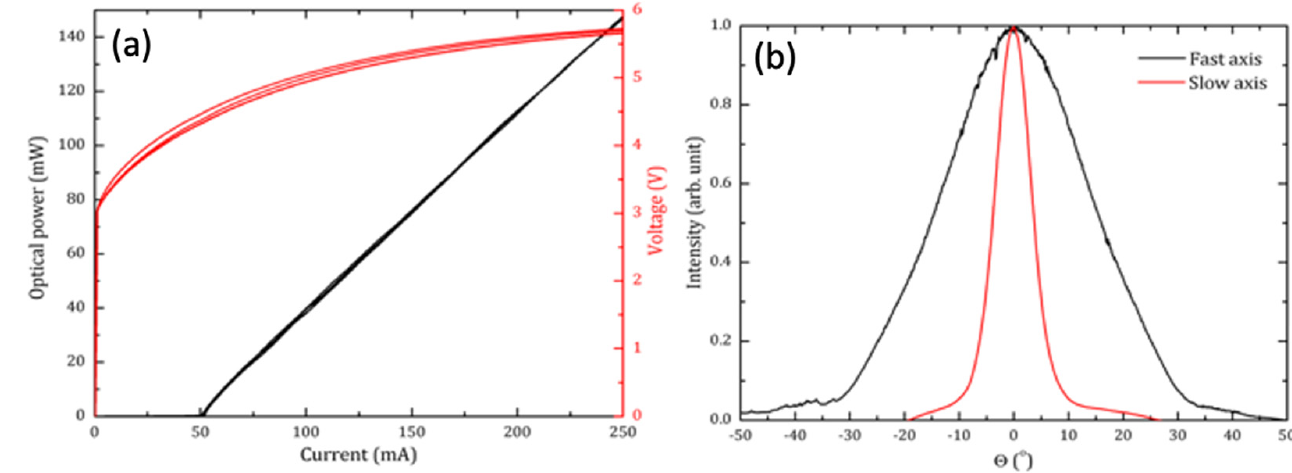
Figure 1. AlGaInN 418 nm laser diode characteristics: ( a ) LIV; ( b ) near-field (slow axis: red line; fast axis: black line).